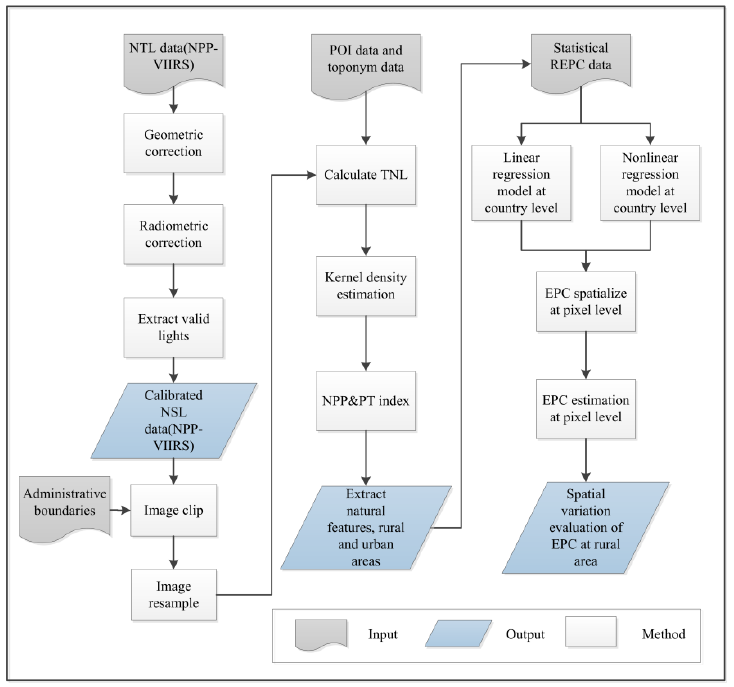
Figure 2. Flowchart of the methodology.